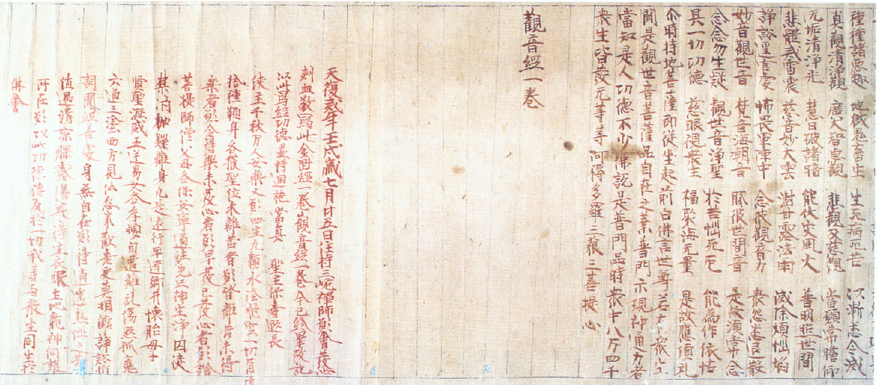
Fig. 4 Fragment of the Guanyin jing 觀 音 經 ( scripture of Avalokite ś vara Bodhisattva ), which is chapter 25 “ The universal Gateway of the Bodhisattva Perceiver of the World ’ s Sounds ” of the Lotus S ū tra that circulated as an independent scripture. This text was done by a certain Chan master who resided near Mt. Sanwei 三 峗 in the southeast part of Dunhuang caves in Gansu Province in 902. In the postscript he is referred to as Chan Master Sanwei 三 峗 禅 师 . The size of the whole fragment measures 4.74 x 10.2 inches. Currently, it is housed in Beijing National Library. Photograph by the author.